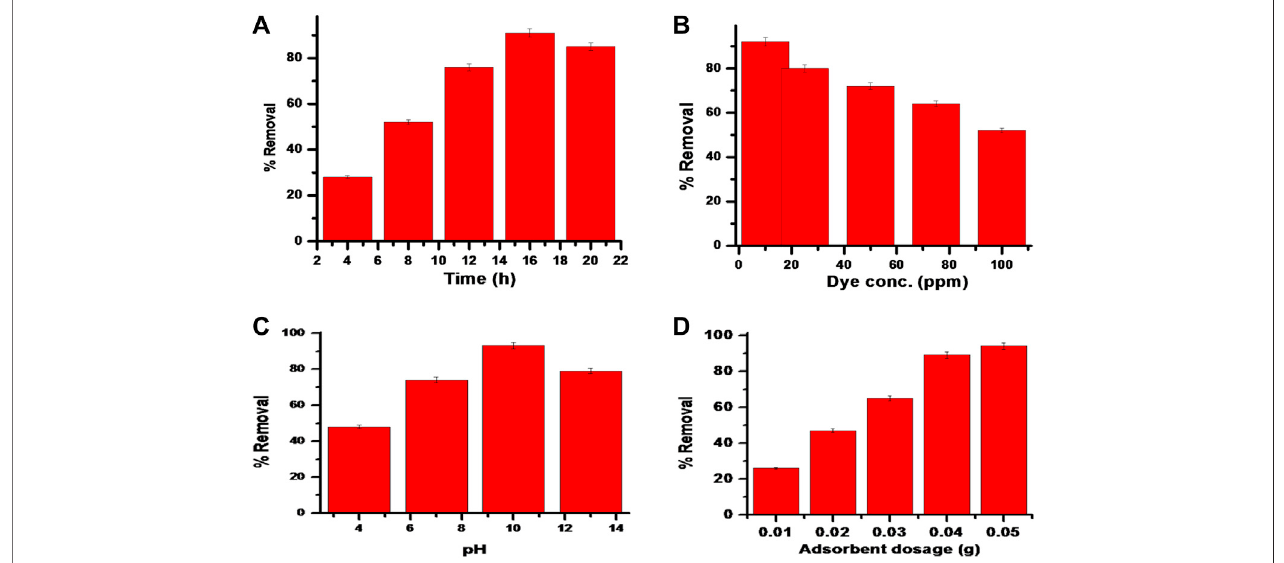
FIGURE8|(A-D) Impactof (A) Time; (B) Dyeconcentration; (C) pHand (D) Adsorbentdosageon%removal ofdye byKg-cl-poly(AA)-Cu-Ni bionanocomposite.